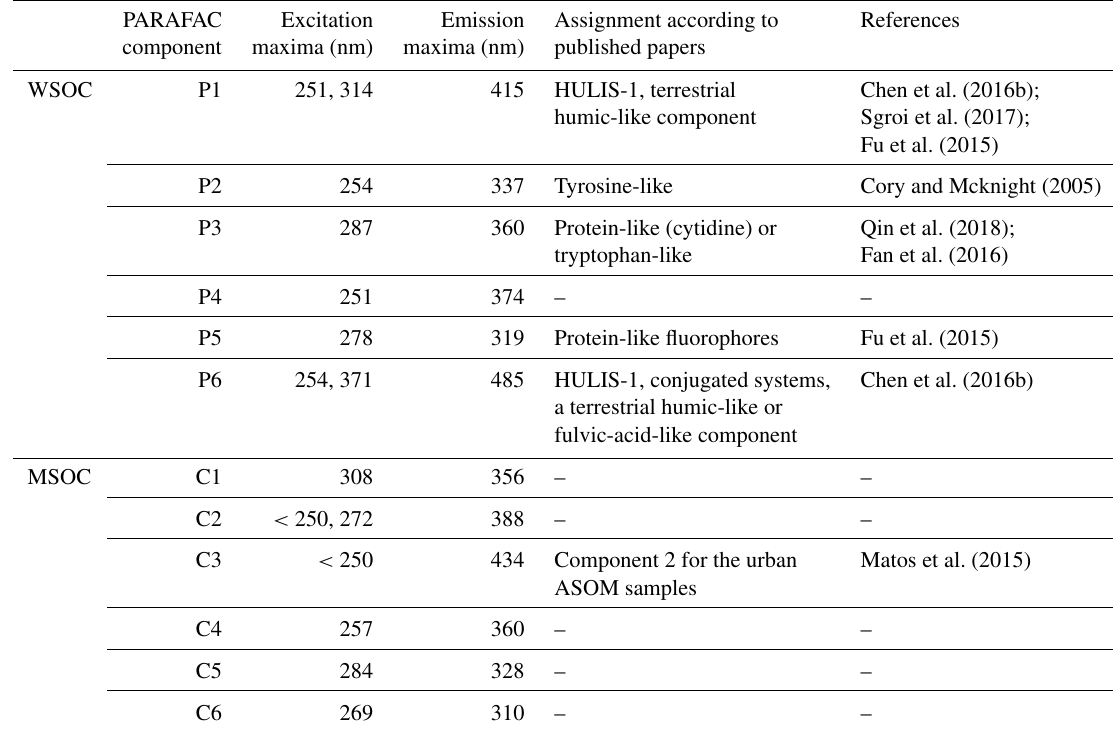
Table 1. The maximum excitation and emission wavelengths of the PARAFAC components in WSOC and MSOC extracted from the three origins.